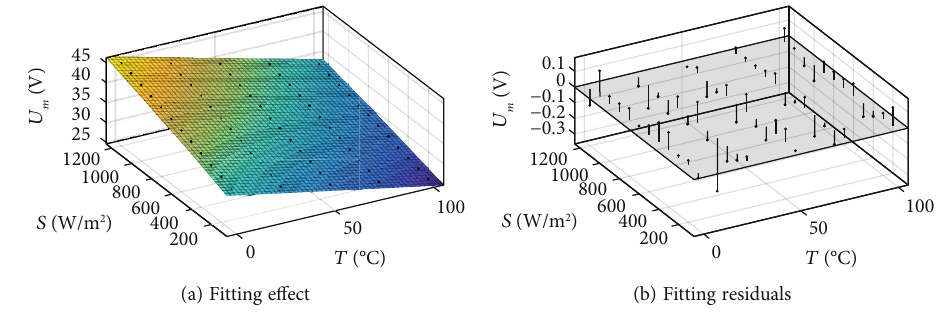
Figure 9: Curve fi tting with Equation (10).